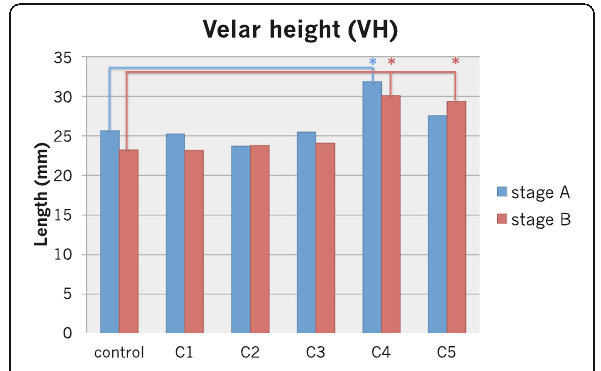
Fig. 6 The length of VH in six conditions at stages A and